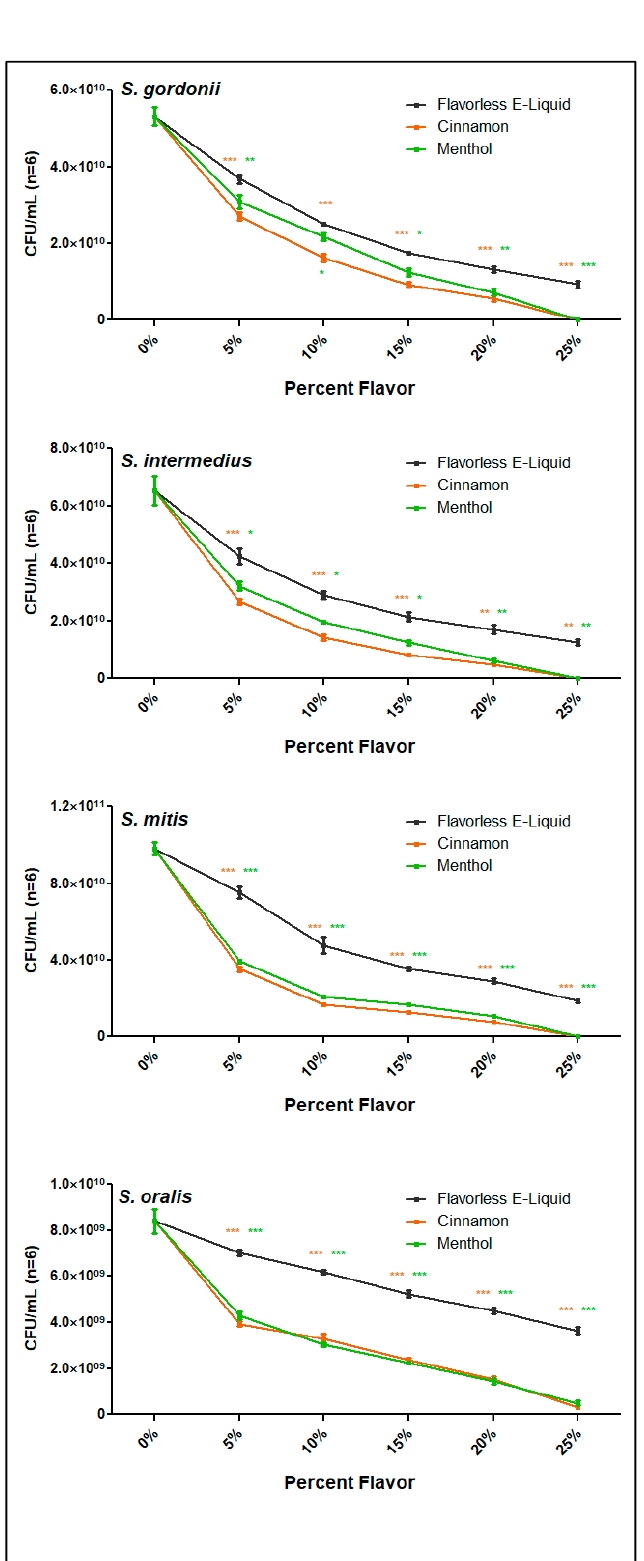
Figure 5. Death Curves of Streptococci after E-liquid ± menthol or cinnamon. Death curves per- formed with all four species of streptococci using E-liquid ± flavors from 0 to 25% in PBS. Each data point represents mean ± SEM (n = 6). Green stars and orange stars indicate significance between flavorless E-liquid and menthol and cinnamon, respectively. * p < 0.05, ** p < 0.01 and *** p < 0.001.